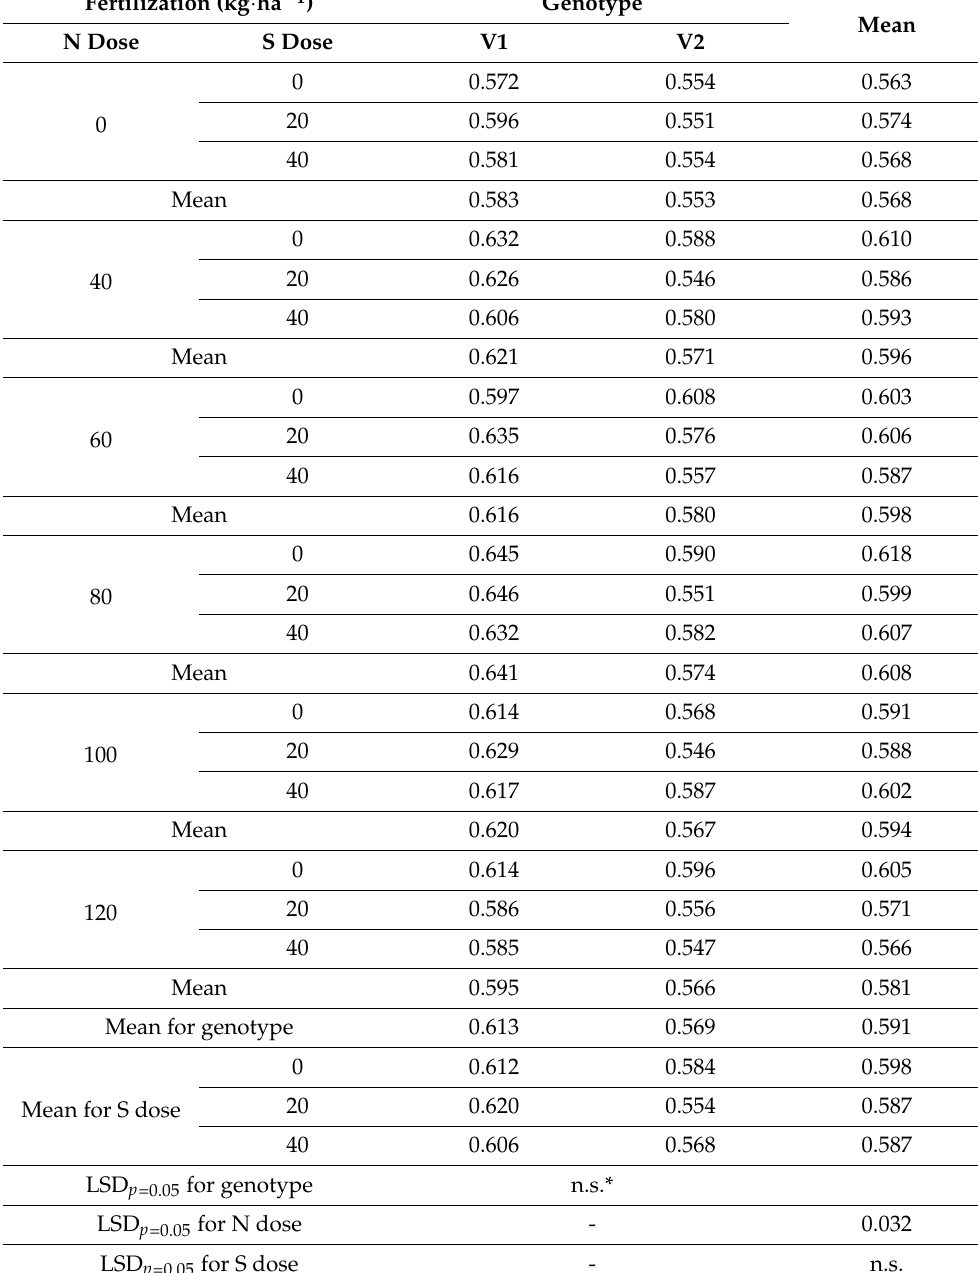
Table 5. CCCI of winter wheat genotypes under